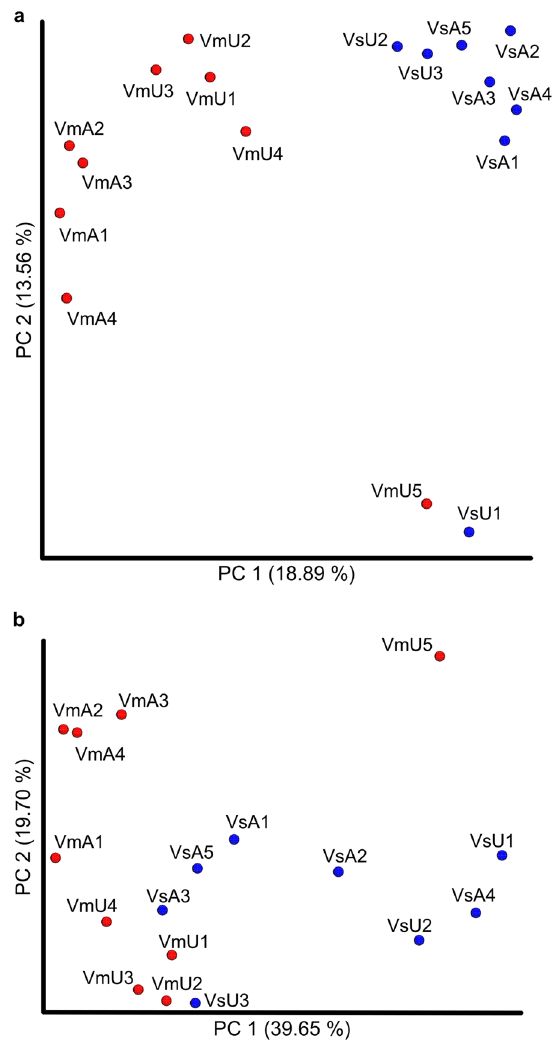
Figure 4. PCoA analysis of hornet gut microbiome samples. ( a ) PCoA plots of Jaccard distance. Each point represents individual sample and clustering of points means similarity in membership of OTUs among those samples. OTU membership was significantly different between host species (P = 0.0004, ANOSIM; P = 0.0002, PERMANOVA, 5000 times of permutations in each test). ( b ) PCoA plots of Bray-Curtis distance. Clustering of points means similarity in relative abundances of OTUs among those samples. Relative abundances of OTUs was significantly different between species (P = 0.007, ANOSIM and PERMANOVA, 5000 times of permutations in each test). Species and sampling locations were represented by sample IDs as follows; Vm and Vs, V. mandarinia and V. simillima , respectively; A and U, AIST and UT, respectively. For instance, VmA1 means V. mandarinia AIST-1. Red, V. mandarinia ; blue, V. simillima